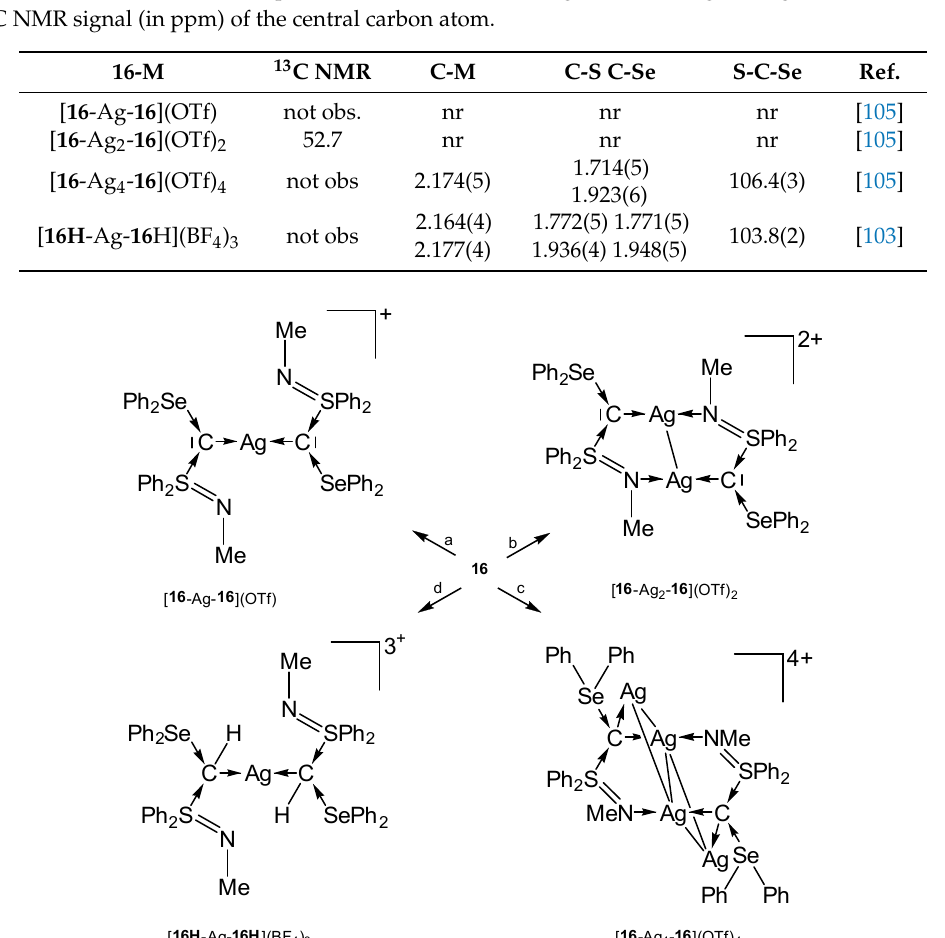
Scheme 25. Transition metal complexes with the carbone 16 as two and four electron donor. (a) 0.5 eq AgOTf, (b) 1 eq AgOTf, (c) 2.0 eq AgOTf, (d) AgBF 4 /CH 2 Cl 2